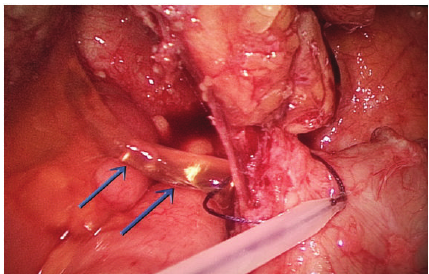
Figure 12: Oozing of mucus from the surface of the appendix (blue arrows),withtheendoloopbeingappliedtothebaseoftheappendix, laparoscopic view (second